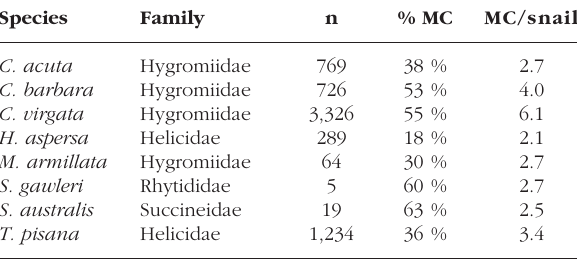
Table II. – Summary of snail families and species examined for B. cribbi metacercariae from southern Australia. n = number of